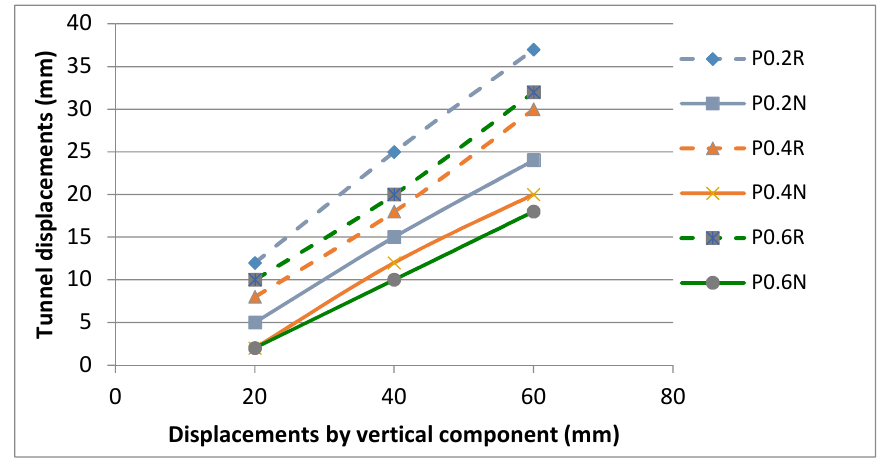
Figure 6. The effect of particle size (D 50 ) in reverse and normal faults. Figure 6. The e ff ect of particle size (D 50 ) in reverse and normal faults.